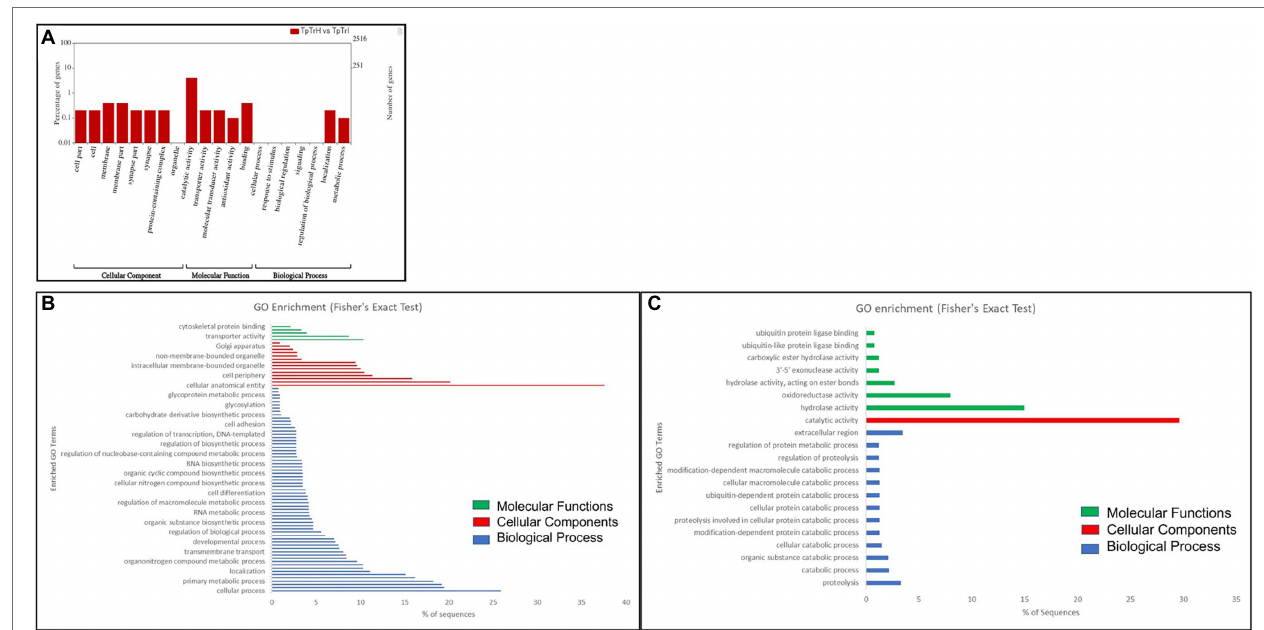
FIGURE 2 | Gene ontology (GO) enrichment analysis of differentially expressed genes (DEGs). (A) DEGs were characterized under cellular components, molecular functions, and biological processes on the basis of GO analysis. GO of differential expressed (B) up- and (C) downregulated genes of viruliferous vs. nonviruliferous thrips populations. Green, red, and blue bars represent molecular functions, cellular components, and biological processes,